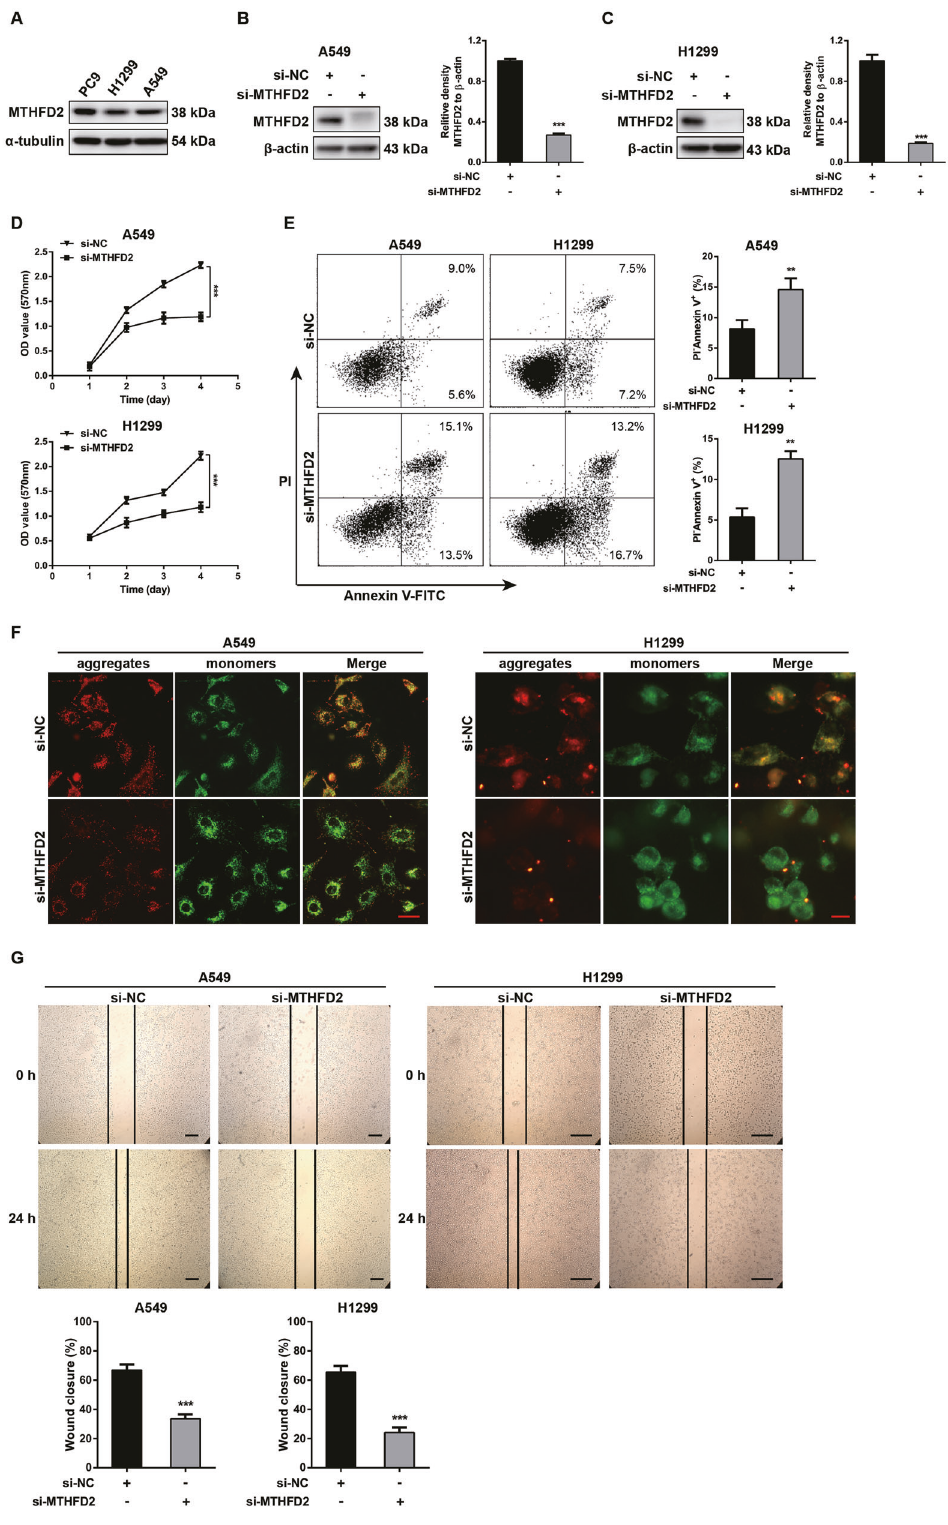
Speci fi c inhibition of MTHFD2 function improves anti-tumor sensitivities induced by pemetrexed in LUAD Pemetrexed is the fi rst-line chemotherapeutic drugs for LUAD patients. To explore whether targeting MTHFD2 together with pemetrexed can improve therapeutic advantages in LUAD, a speci fi c MTHD2 inhibitor, DS18561882, was used in the